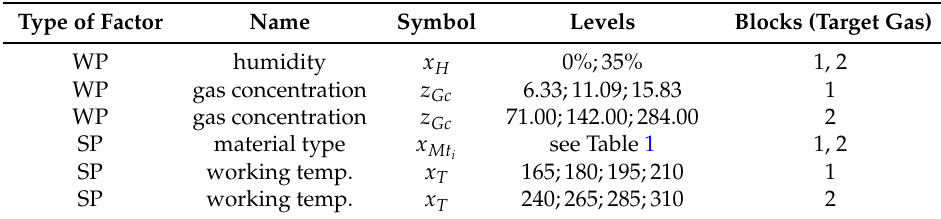
Table 2. Experimental factors. WP, Whole-Plot; SP,